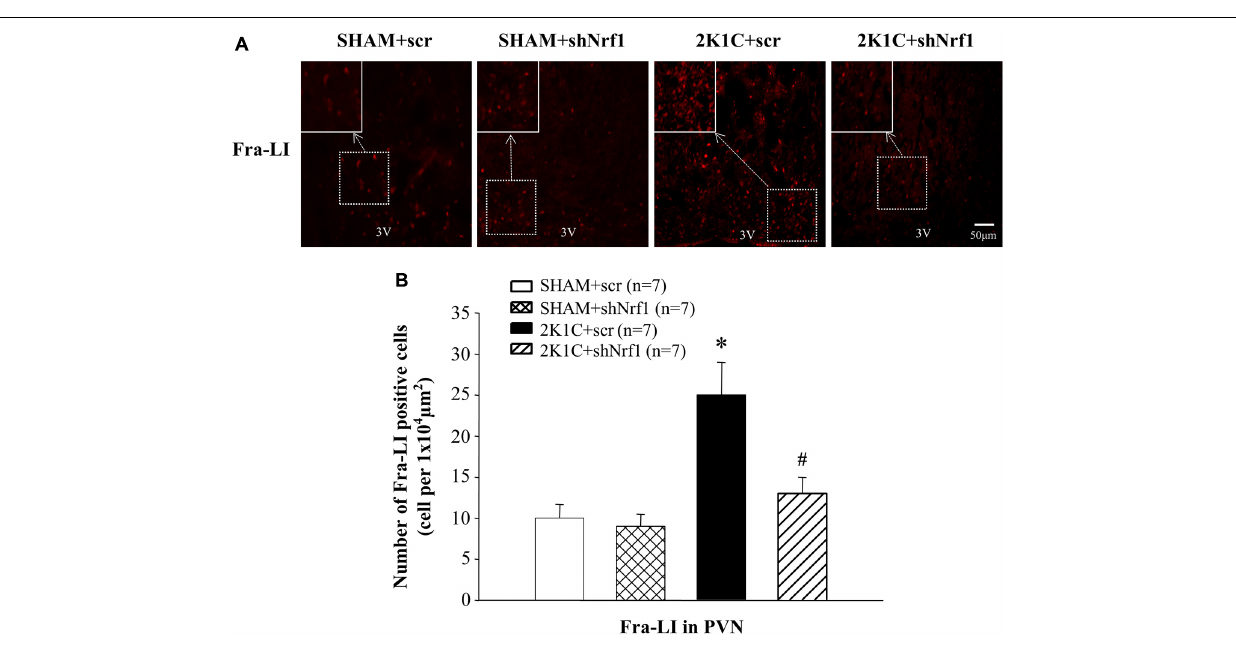
anesthetized rat was placed on its right side on the bench, and a 2 cm longitudinal incision was made starting at the level of the third lumbar vertebra and 1 cm left to the spine to expose the left kidney. Separate the adipose tissue around the kidney and expose